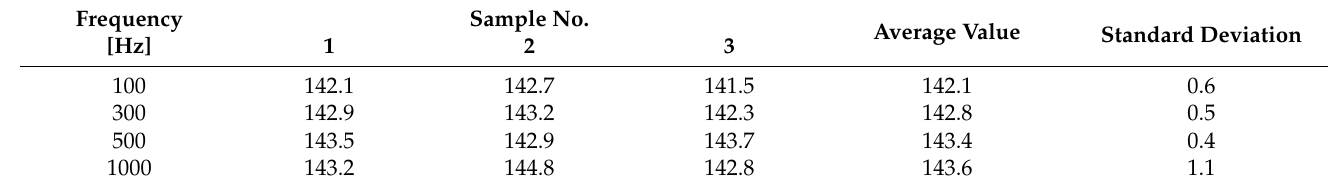
Table 5. Dynamic stiffness (dB re. 1 N/m) for PSMA8 poroelastic pavement with SMA11 as binder course—measurements in situ (S).